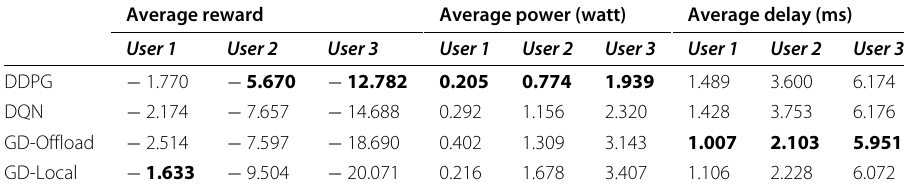
Table 2 Comparison of testing results with w m = 0.5 for all mobile users Average reward Average power (watt) Average delay